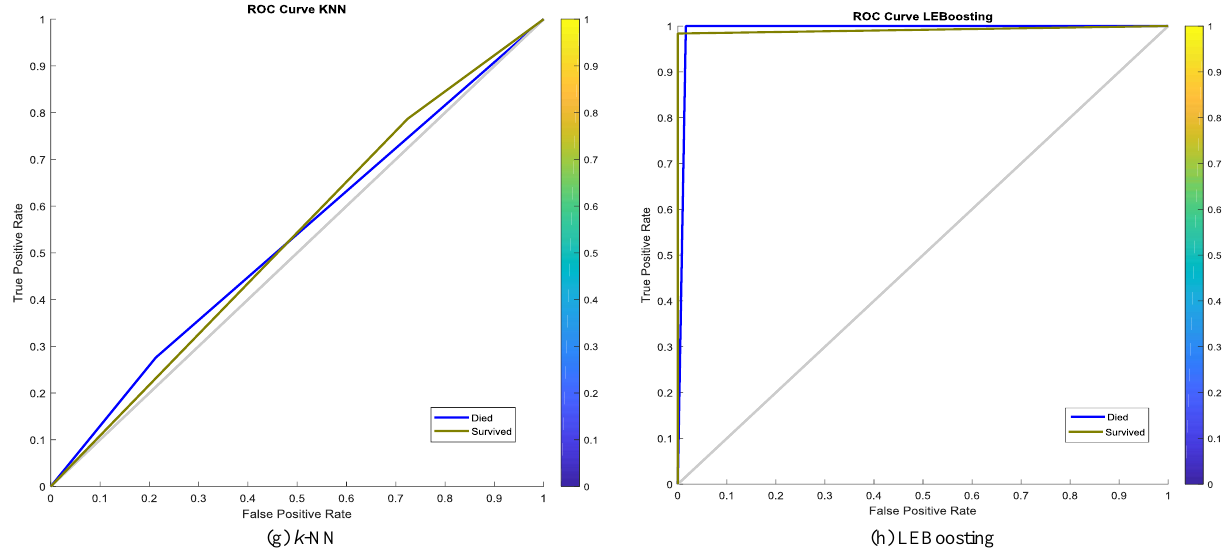
Figure 4. Comparison of the ROC curve of the various methods that have been tested It is a curve plotted between sensitivity and 1-specificity. It was found that the LEBoosting graph shows the most accurate performance in the classification test between heart failure and the died class and the least error compared to other ensemble methods.